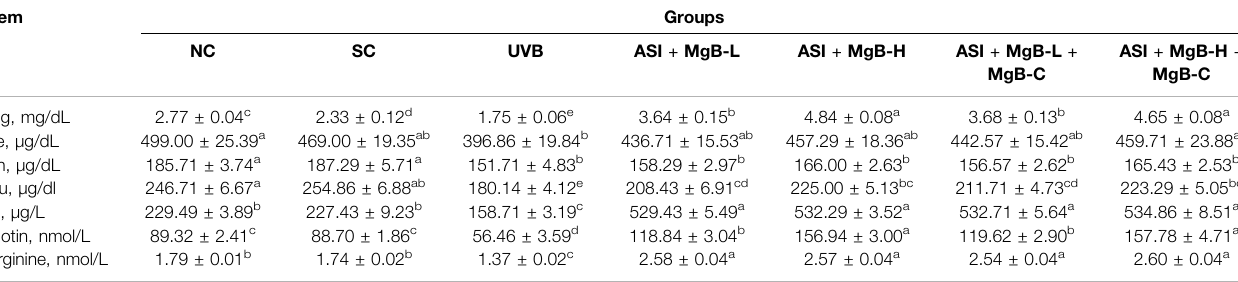
TABLE 2 | Effect of inositol-stabilized arginine silicate complex (ASI) and magnesium biotinate (MgB) on serum minerals, biotin, and arginine levels in rats with UVB-induced